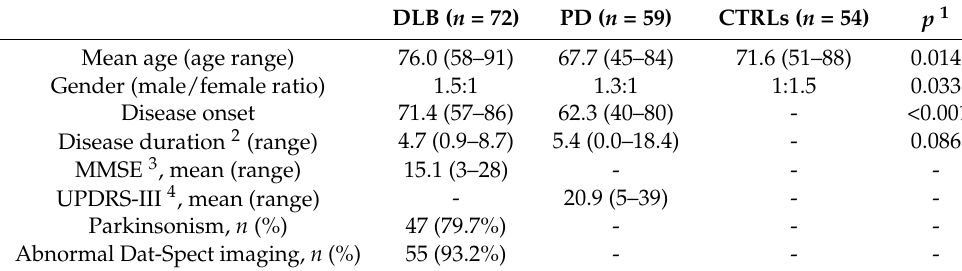
Table 2. Demographic and clinical data of the participants of the